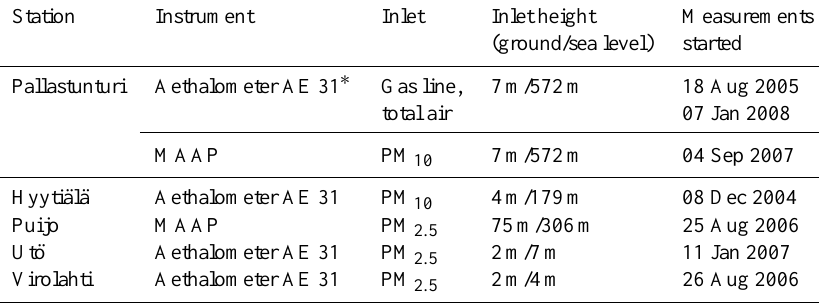
Table 2. Measurement details for each